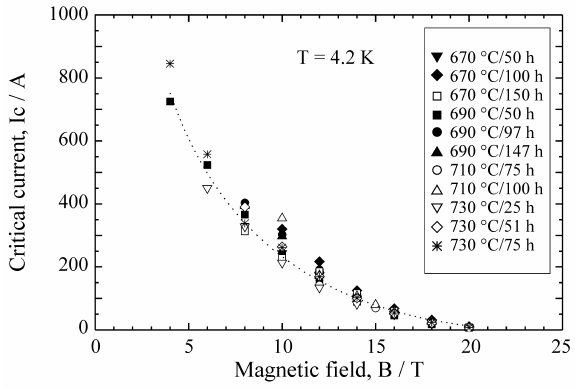
Figure 4. Critical current versus applied magnetic field for the (Nb,Ta) 3 Sn superconductor wire. Comparison between all samples. The measurements were performed at 4.2 K.